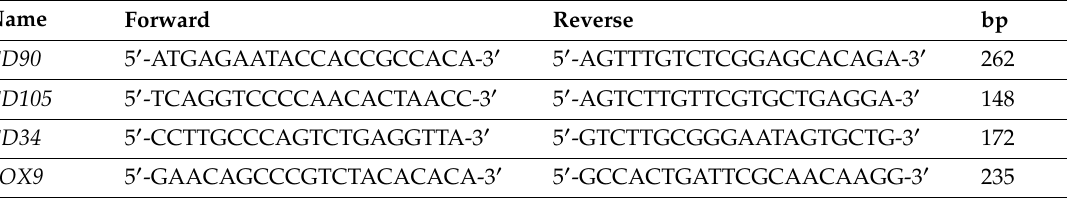
Table 2. Real-Time PCR primer